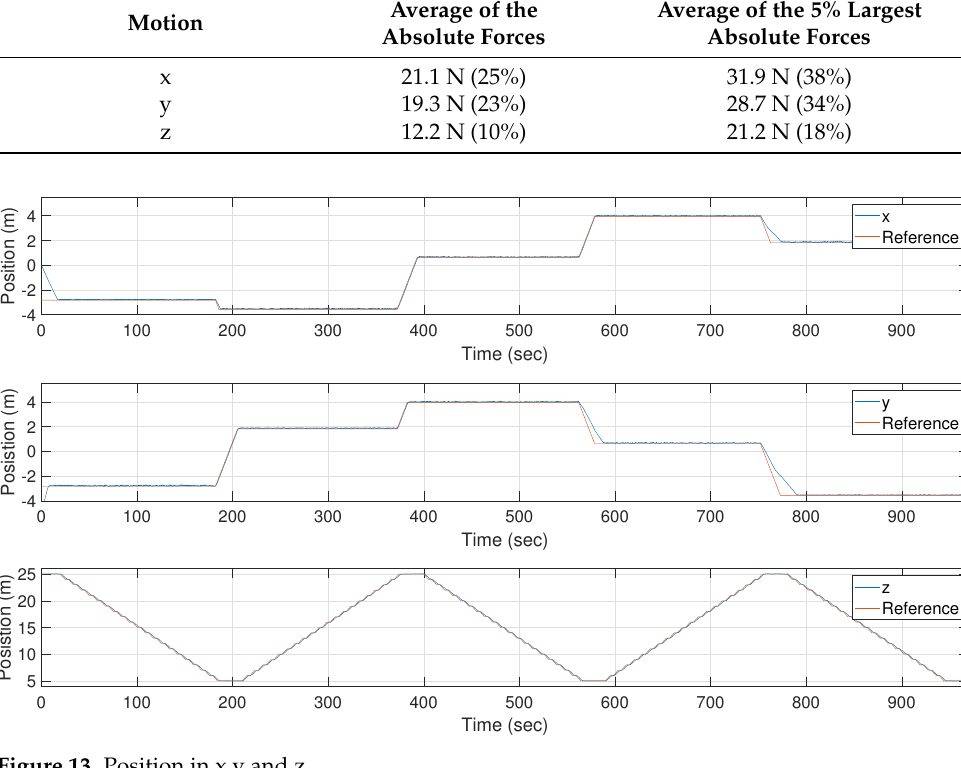
Table 9. Average and maximum tether forces during the inspection campaign. The number in parentheses is the percentage of the maximum thrust force.